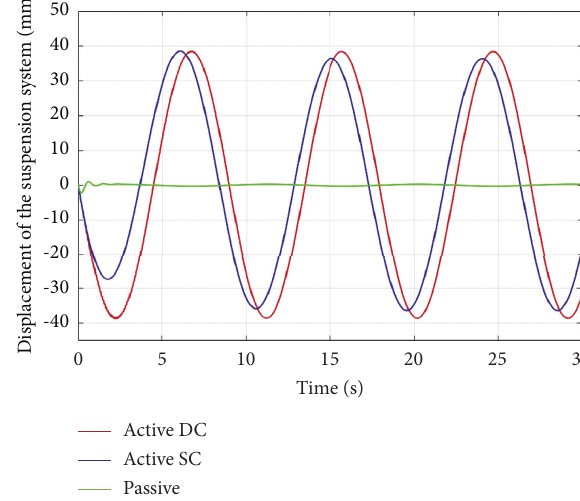
Figure 7: Displacement of the suspension system.